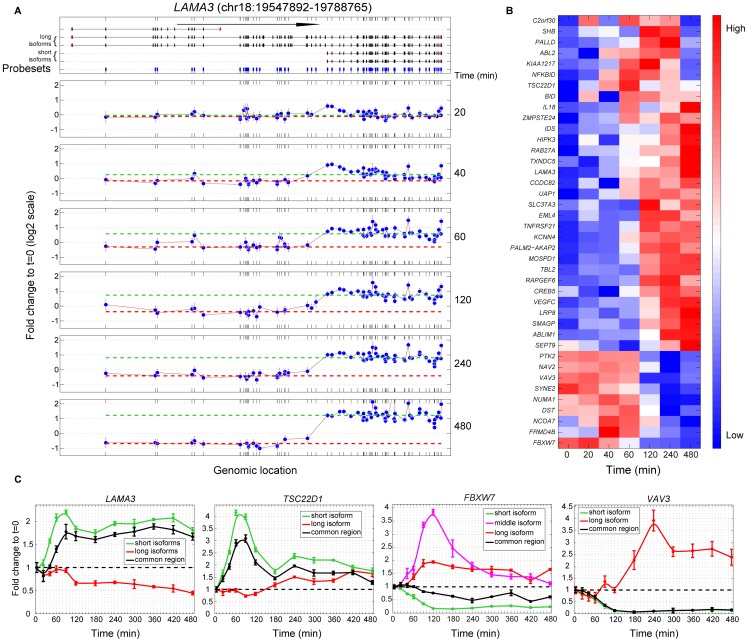
EGF-induced alternative promoter usage.(A) Upper panel: Organization of LAMA3 transcripts as defined by the UCSC gene model. Vertical boxes represent exons; the arrow (100 kb) indicates the direction of transcription. Positions of exonic PS (blue) that passed all filtering steps are indicated. The upmost isoform was not expressed in MCF10A cells (neither of two isoform-specific PS interrogating the alternative last exon passed the required signal intensity threshold). Lower panels: FC (log2 scale) of each PS with respect to pre-stimulus values is shown for each time point. Only PS with ‘present’ calls in all replicates are depicted at each time point. Bars represent standard errors of FC from three biological replicates. Note strong induction of the 3′ portion (the dashed green line marks the median FC of this region). In contrast, the longer isoforms (median FC shown by the dashed red line) are slightly downregulated. (B) The heat map displays the FC ratios of the short to long isoforms of the top 40 genes identified as undergoing EGF-induced alternative usage of well-annotated promoters (FDR<1%) resulting in alternative first exons; if the relative abundance of the short isoforms compared to the long isoforms increases after EGF stimulation the FC ratio becomes ‘high’ (see for instance LAMA3) (C) For qPCR validation of TIV events primer pairs specific to transcript isoforms were used for each gene, along with pairs spanning regions common to all transcripts. Error bars represent standard deviations from three technical replicates. The experiment was repeated twice.